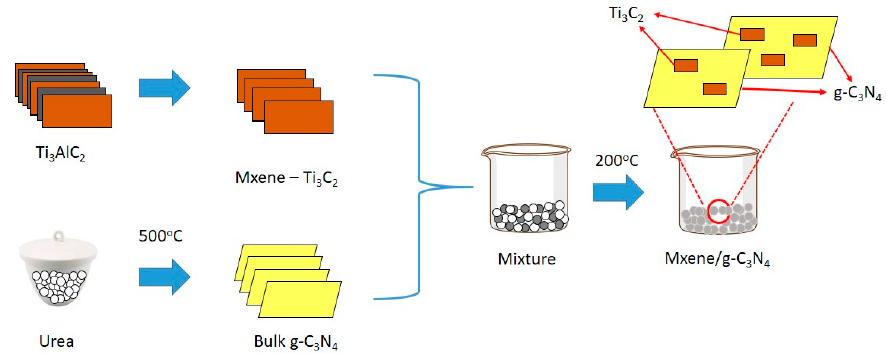
Figure 1. Schematic diagram of the MXene/g-C 3 N 4 photocatalyst synthesis